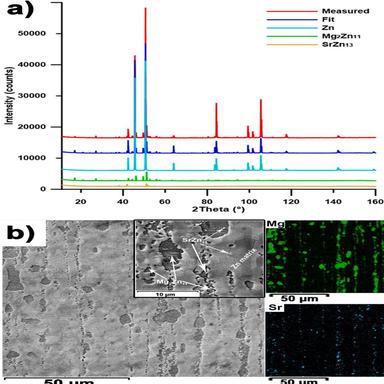
a) XRD patterns of the studied Zn-0.8Mg-0.2Sr alloy, a Rietveld fit and theoretical XRD patterns of the individual phases. b) SEM micrograph and X-ray elemental maps (SEM-EDX) of Mg and Sr showing the distribution and size of the individual phases.